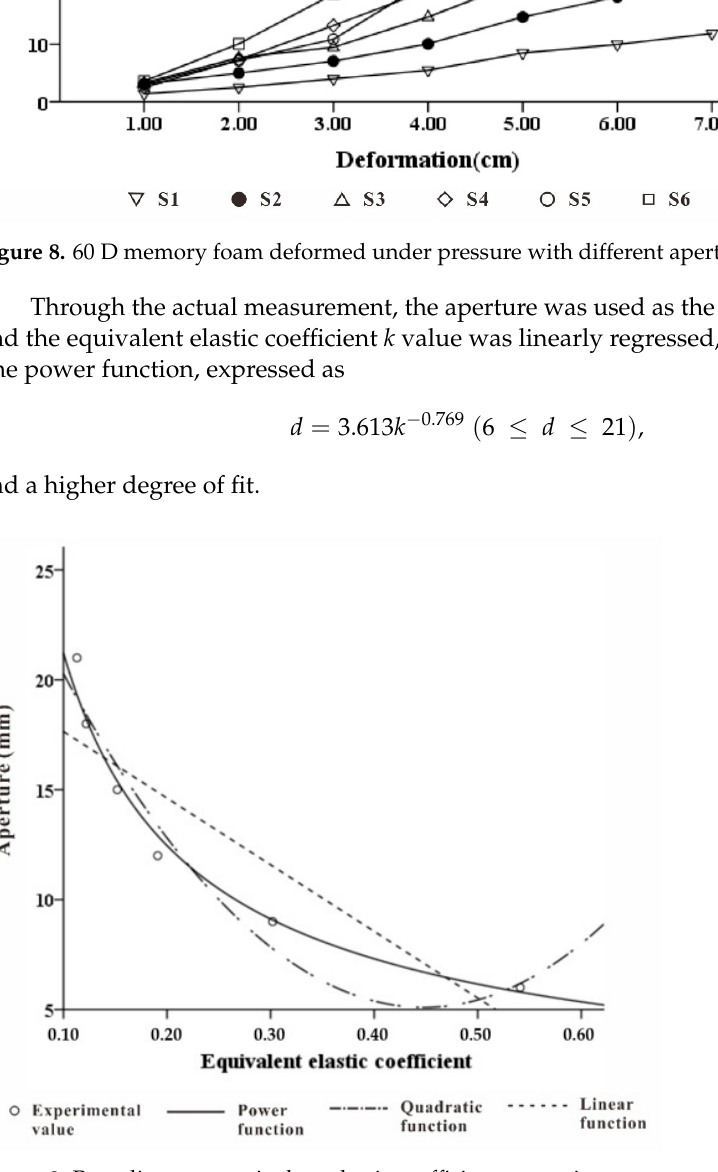
( c ) Figure 10. ( a ) Hole array distribution. ( b ) 3D model. ( c ) Prototype. Table 8. Error of equivalent elastic coefficient of each partition for men with small physique. A1